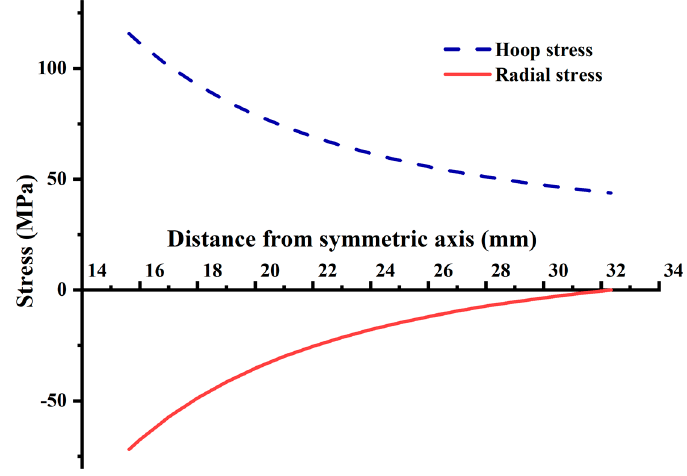
Figure 12. Stress distribution of the tray caused by small hole expansion.